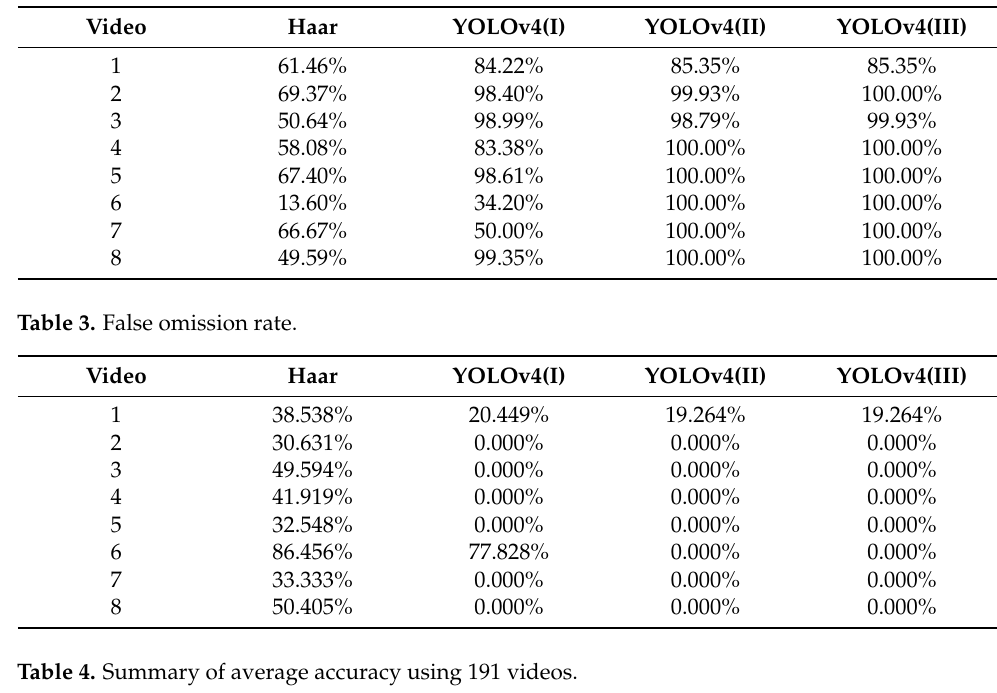
Table 2. Accuracy rate.